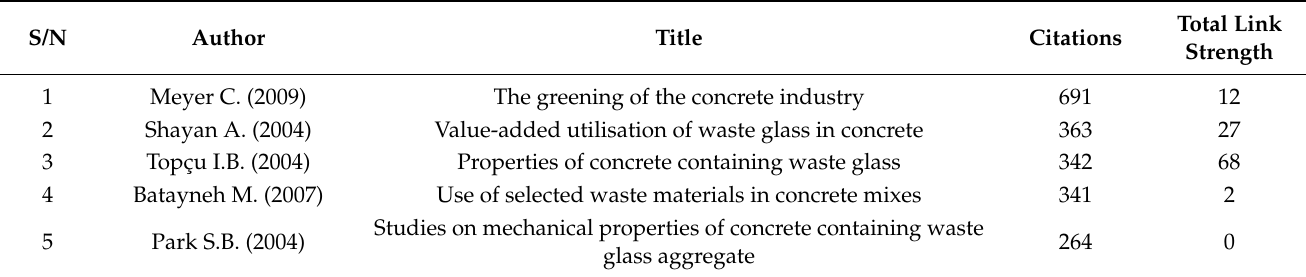
Table 4. Top 20 publications based on citation